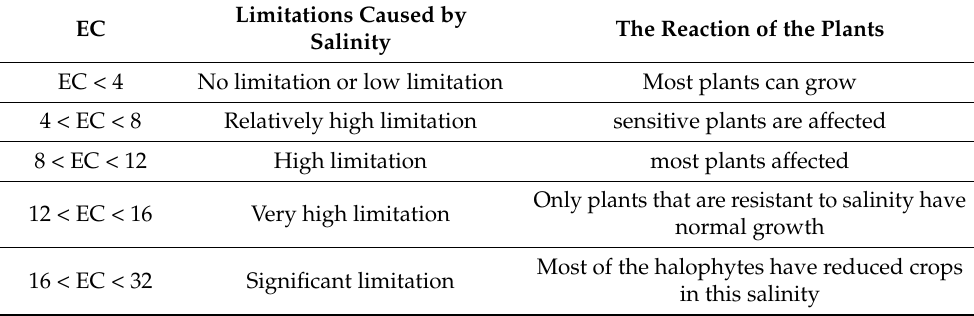
Table 9. Classification of soils based on their salinity